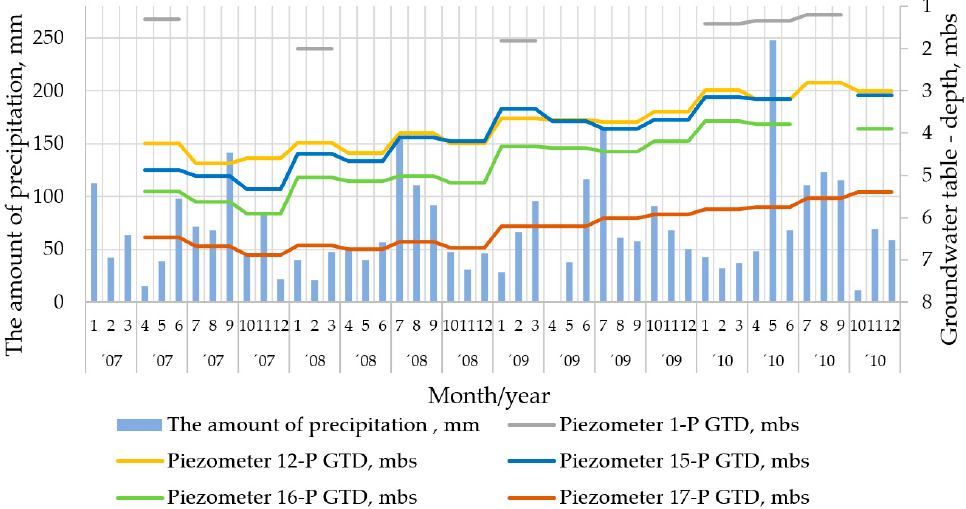
Figure 4. Free groundwater table depth (GTD) below the surface level (in meters below surface, mbs) for piezometers: P1, P12, P15, P16, P17. The location of piezometers in the vicinity of waste heap is shown in Figure 1b.